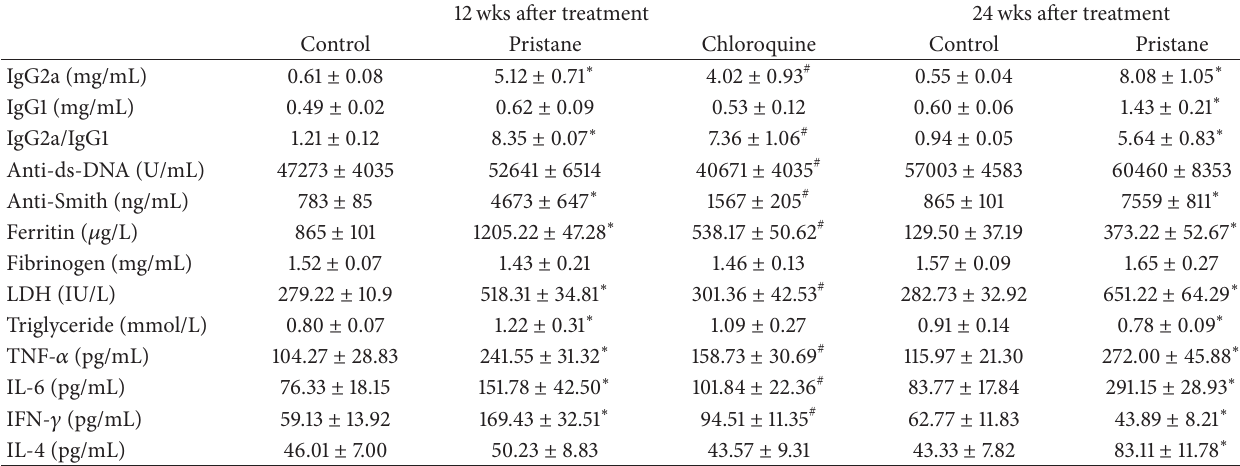
Table 3: The levels of cytokine, IgG2a, IgG1, anti-ds-DNA, anti-Sm, ferritin, fibrinogen, LDH, and triglyceride in